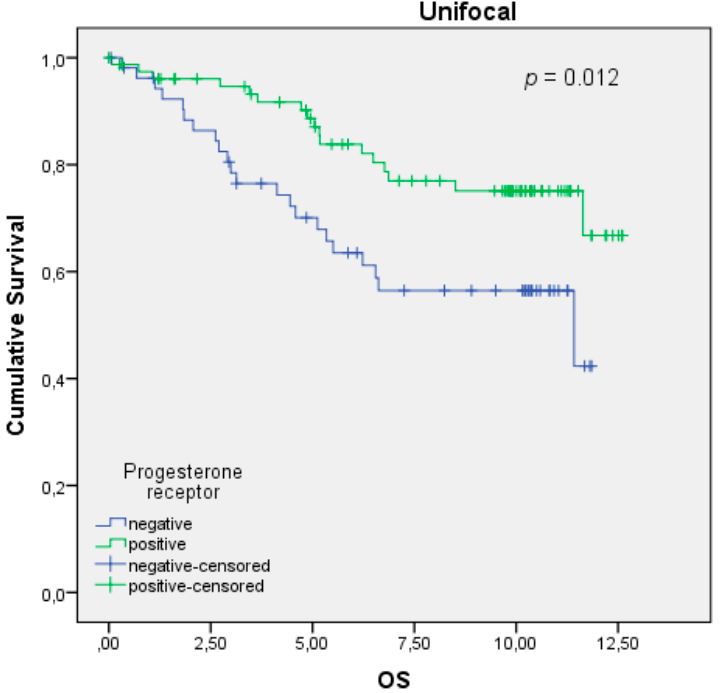
Figure 2. Kaplan–Meier survival analysis among PR-positive and -negative patients. OS of patients with unifocal BC in years. Table 3. Significant results for the progesterone receptor-positive patients.